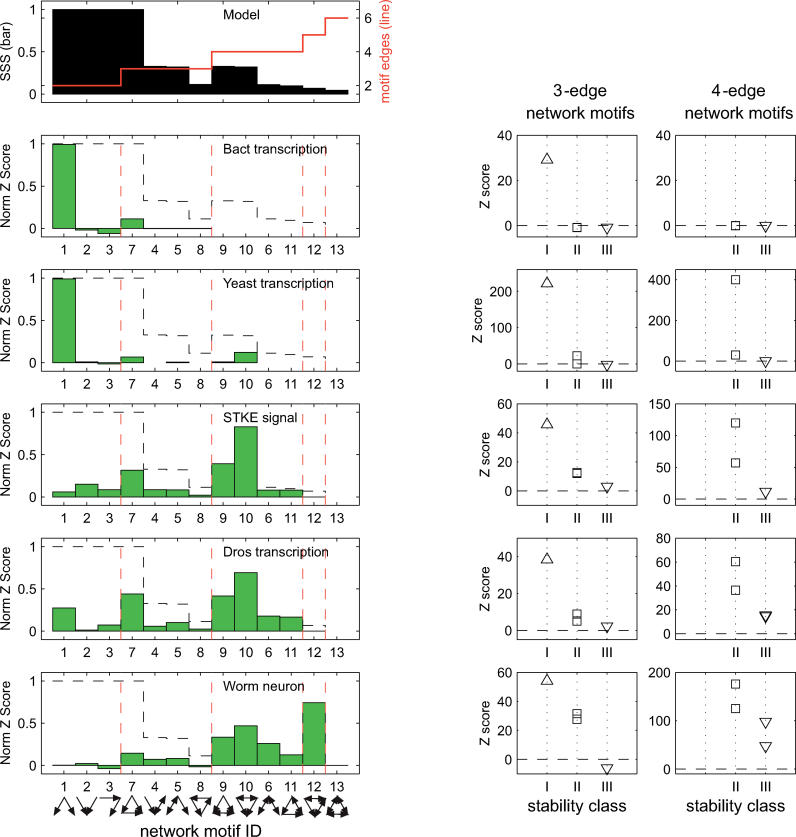
Distribution of Normalized Z Scores of Three-Node Network Motifs (Left), and Z Scores Classified by Stability within Specific Density Groups (Right)(Top panel, left) All 13 network motifs are sorted on the x-axis first, according to increasing number of edges (solid red line). For a given number of edges, they are then sorted from high to low SSS (black bars).(Bottom five panels, left) Normalized Z scores (green bars) for all 13 motifs of the transcriptional networks of E. coli and S. cerevisiae, STKE network, D. melanogaster developmental transcriptional network, and C. elegans neuronal network, shown with outlines of the SSS from the top panel (dotted black outline provided as a guide to the eye). Each vertical red line indicates a change in the number of motif edges, indicating boundaries of density groups.(Right) Z scores of network motifs in the three-edge and four-edge density groups are plotted in columns labeled I, II, and III, corresponding to the three stability classes, SSS = 1, SSS ≈ 0.4, and SSS < 0.2, respectively. Note that the four-edge density group does not contain any motifs with SSS = 1 since four edges among three nodes dictates at least one feedback loop.